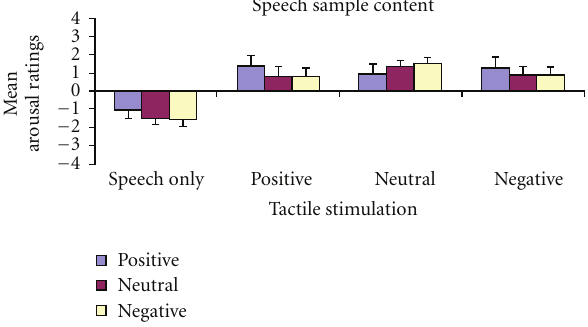
Figure 7: Means and SEMs for the ratings of the pleasantness by the speech sample content and the tactile stimulation.